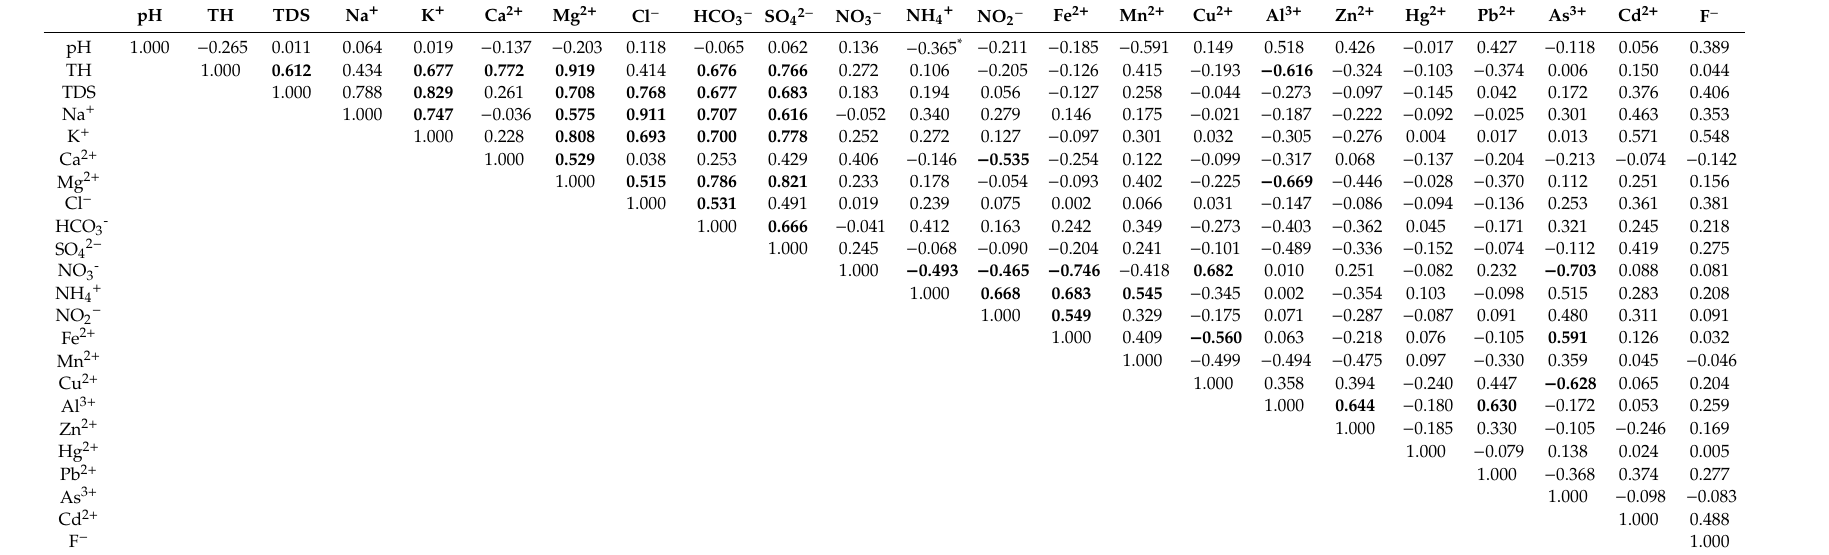
Table 2. Correlation matrices of hydrochemical parameters of shallow